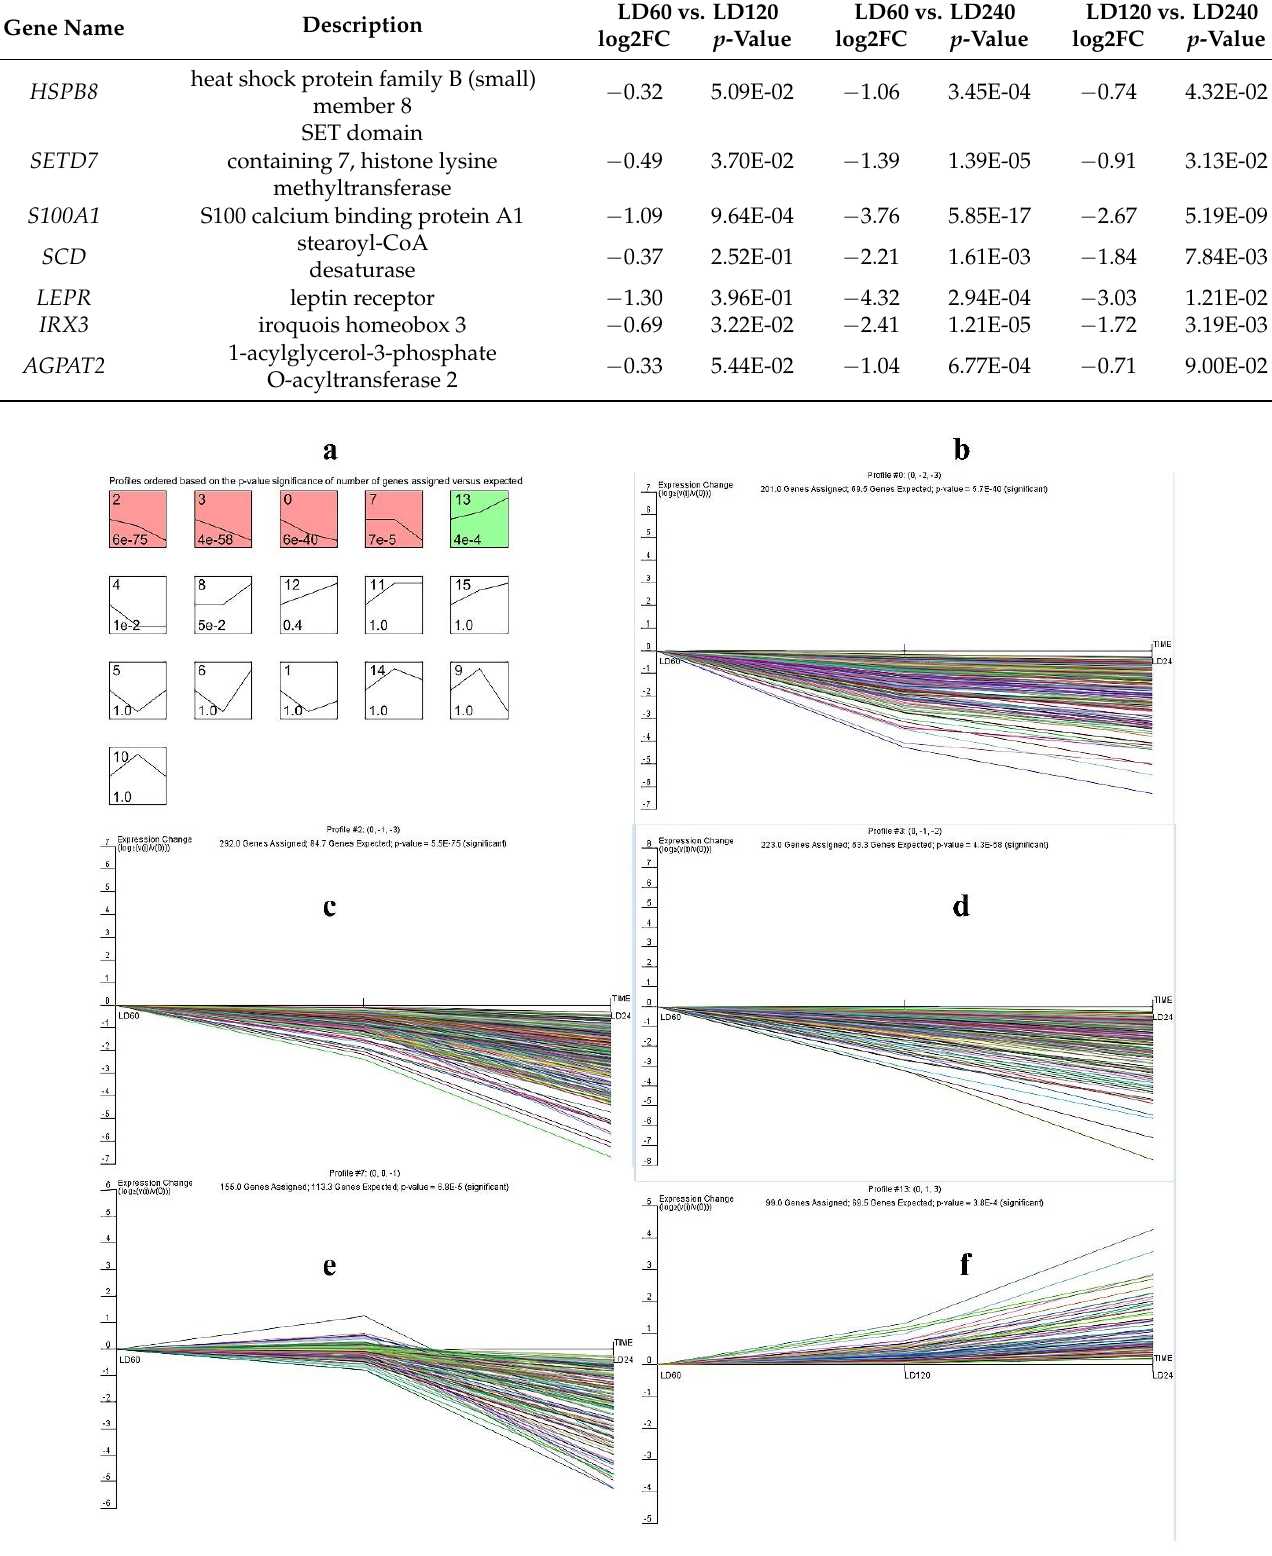
Figure 5. STEM cluster analysis of DEGs at different developmental stages in WH pigs. ( a ) A total of sixteen DEG patterns were obtained at different developmental stages of WH pig. ( b – f ) Five expression patterns of DEGs were significantly enriched in WH pigs.